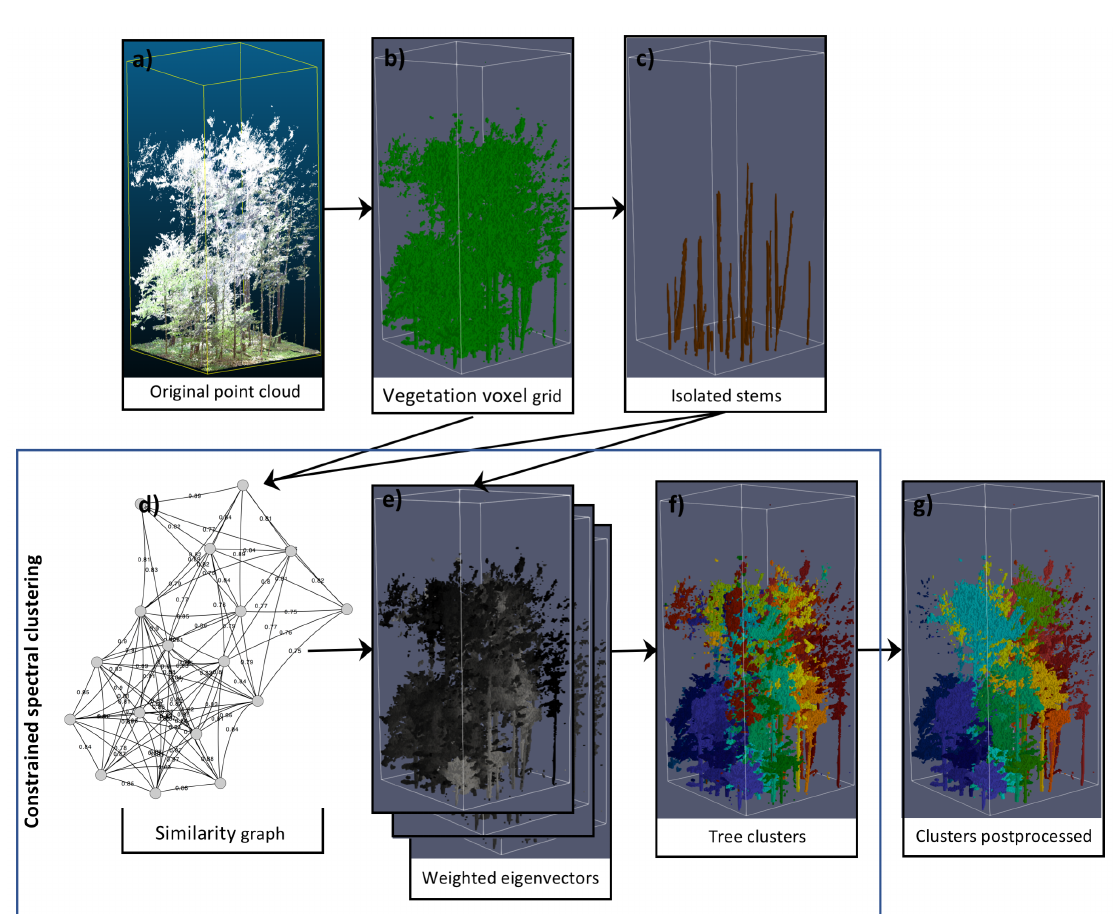
Figure 2. Illustration of the overall workflow for single tree segmentation. For the main steps, intermediate results are visualized by using a plot quadrant as example. ( a ) shows the initial point cloud overlaid with red-green-blue (RGB) photographs for visual appearance; ( b ) depicts the vegetation voxel grid after preprocessing; ( c ) illustrates the isolated tree stems. The vegetation image and the tree stems were used to build the similarity graph in ( d ). Afterwards, the eigenspectrum of the graph was computed and weighted using stem information; ( e ) visualizes single vectors of the spectrum as image stack; ( f ) shows the tree clusters after labelling in a Markov Random Field (MRF) framework. Final results after postprocessing are illustrated in ( g